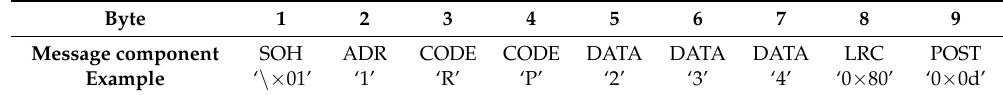
Table 2. Example of a message for a command to move the piston to position “234”.